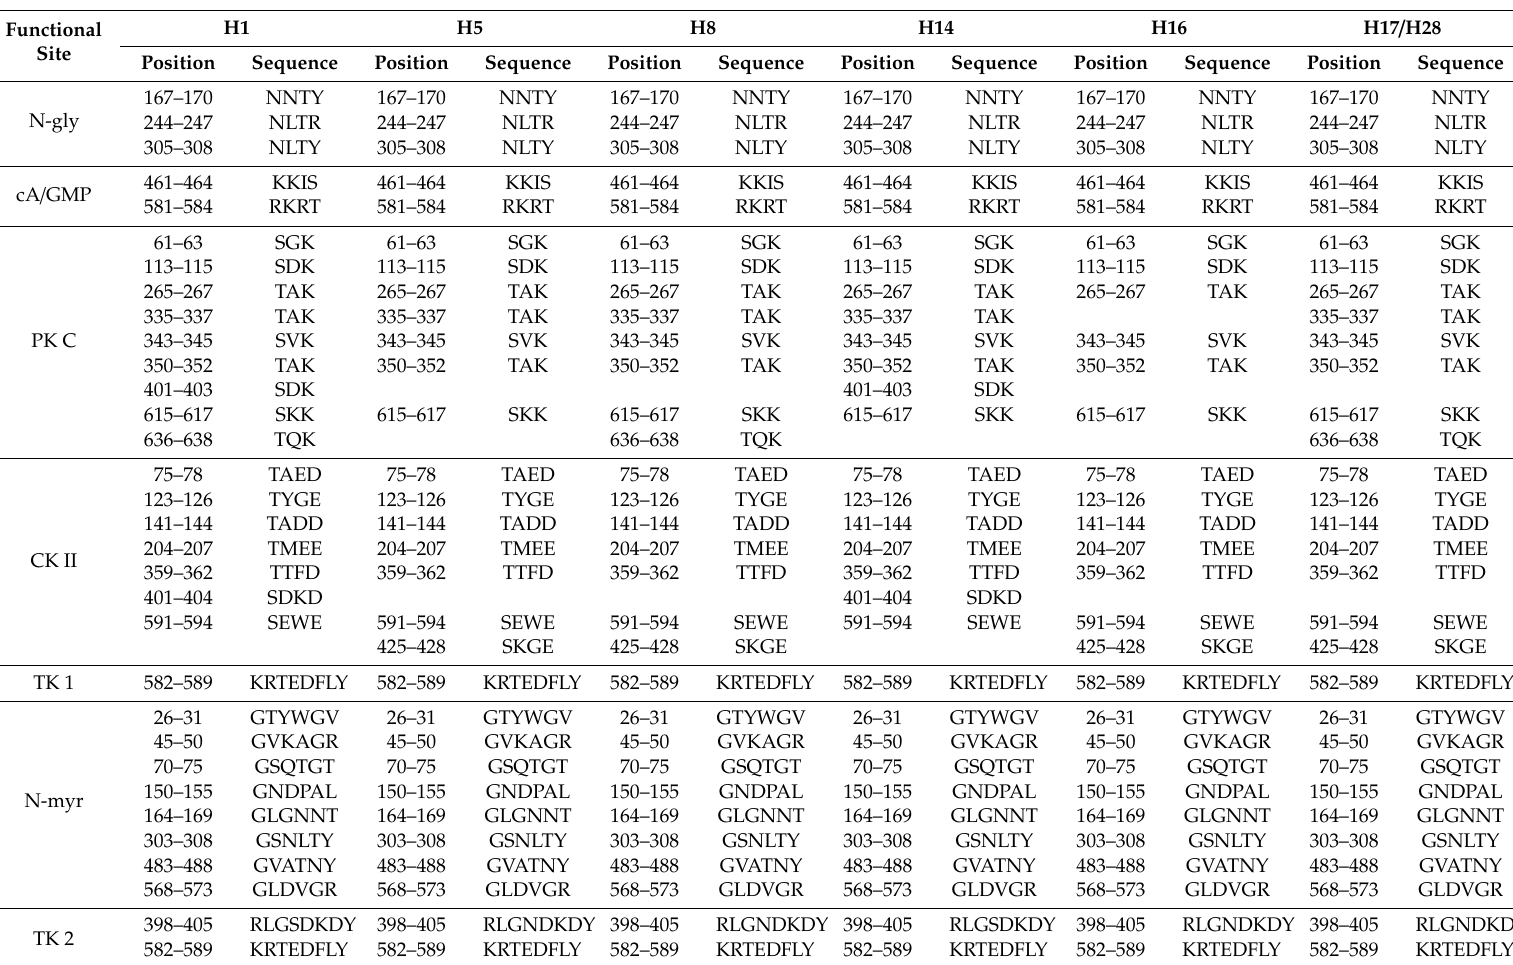
Table 3. Predicted protein motifs of NADP. H-cytochrome P450 reductase-1 encoding by di ff erent haplotypes of O. sinensis